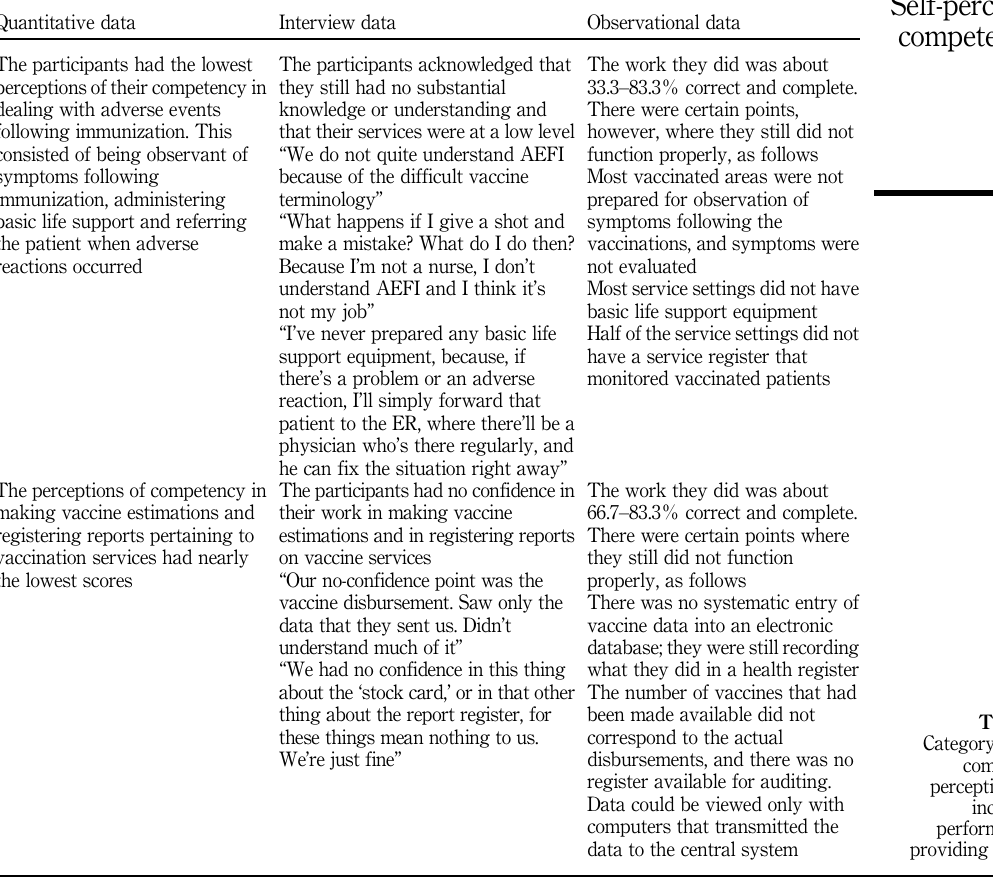
Table V. Category III: